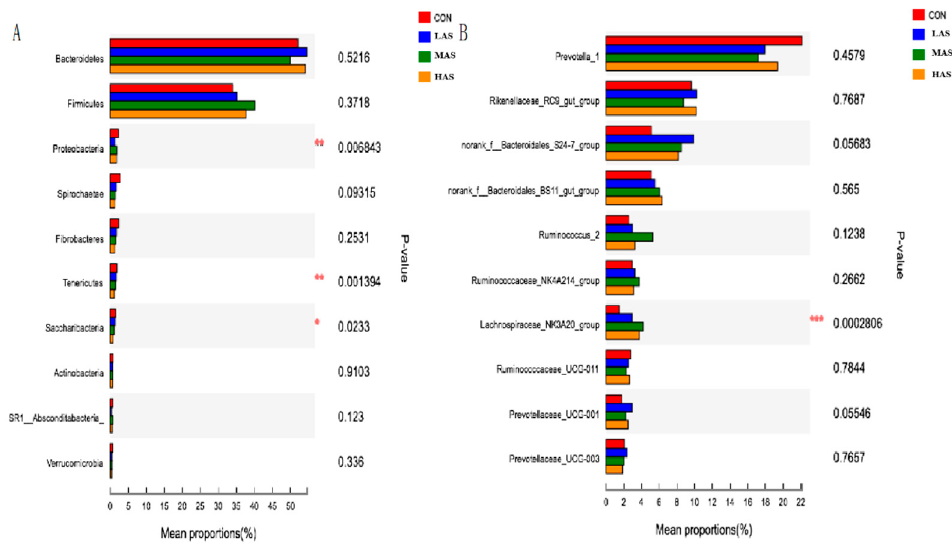
Figure 5. Difference test of bacterial communities in the phylum ( A ) and genus ( B ) level in different groups. CON-S (%DM) 0.4%; LAS-S (%DM) 0.6%; MAS-S (%DM) 0.8%; HAS-S (%DM) 1.0%. Asterisk means significant difference between treatments.